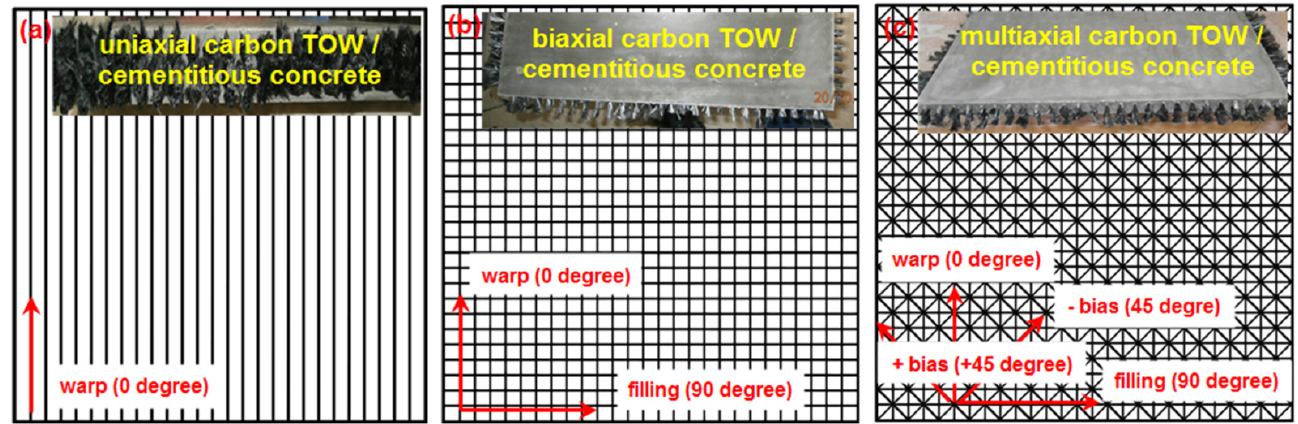
Figure 2. Schematic and actual view of multiaxis 3D carbon fiber concrete composites. ( a ) uniaxial (0°) (C-1D); ( b ) biaxial (0°/90°) (C-2D) and ( c ) four direction (90°/±45°/0°) (C-4D) (digital image).